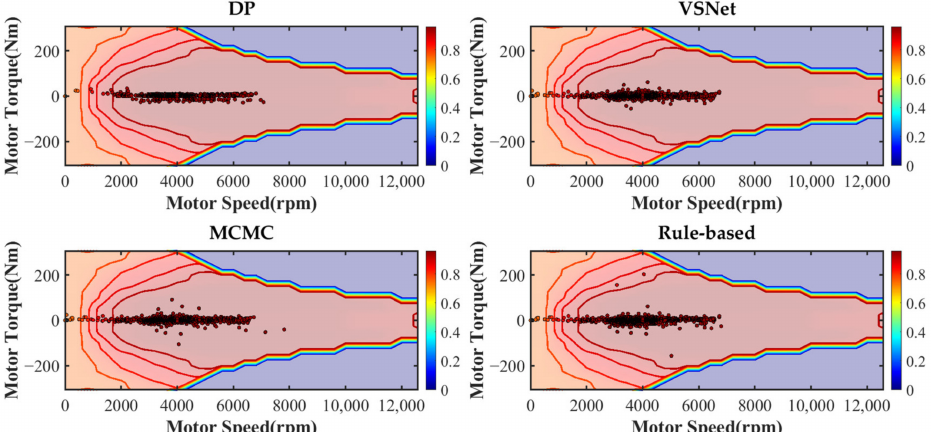
Figure 23. The distribution of motor operating points under various